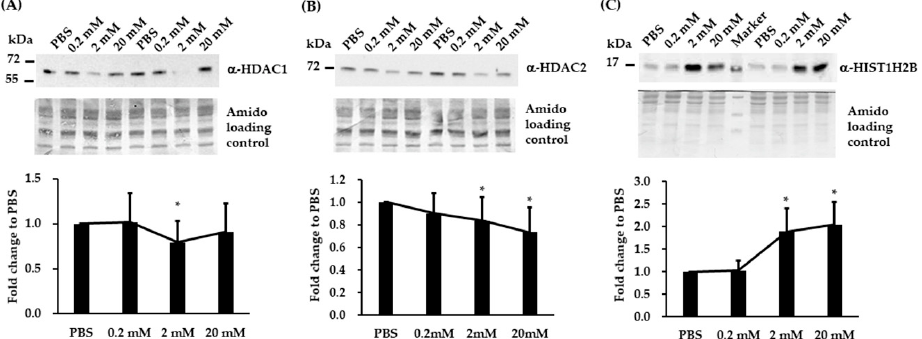
Figure 3. VPA induces the differential expression of the epigenetic regulators HDAC1, HDAC2, and HIST1H2B in SH-SY5Y cells. ( A – C ) Representative immunoblots and quantification of target protein band intensities for lysates from SH-SY5Y cultures treated with the indicated VPA concentration or PBS (control). ( A ) HDAC1. ( B ) HDAC2. ( C ) HIST1H2B. The results are expressed as means ± SD. A statistically significant difference between VPA and PBS was detected by ANOVA (* p < 0.05, n = 5 to